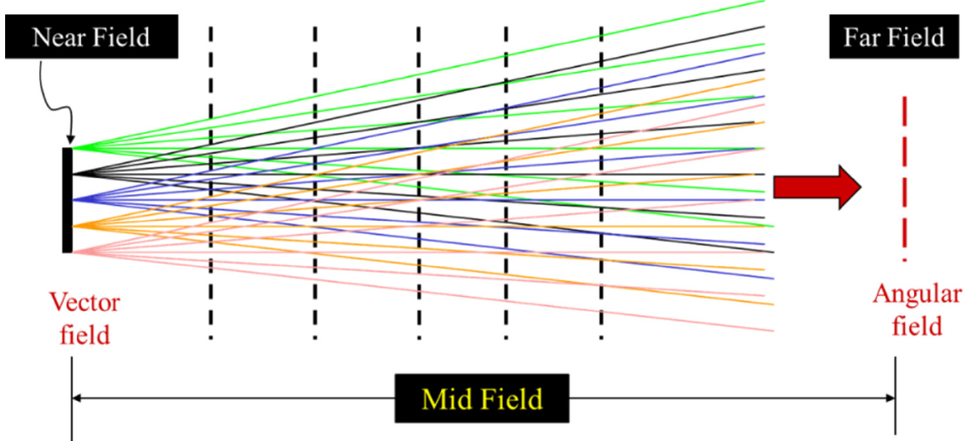
Figure 1. Different illuminance fields for different observation distances. Figure 1. Di ff erent illuminance fields for di ff erent observation